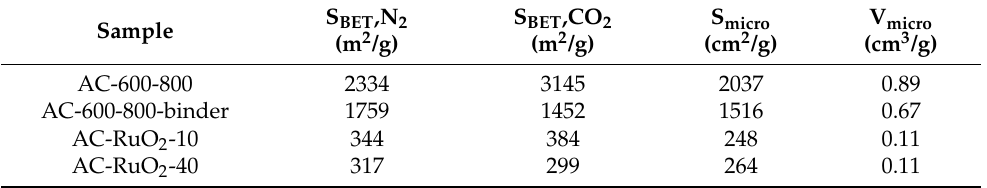
Table 2. BET SSA of the activated carbon AC-600-800 and the composites AC-RuO 2 -10 and AC-RuO 2 -40. Sample